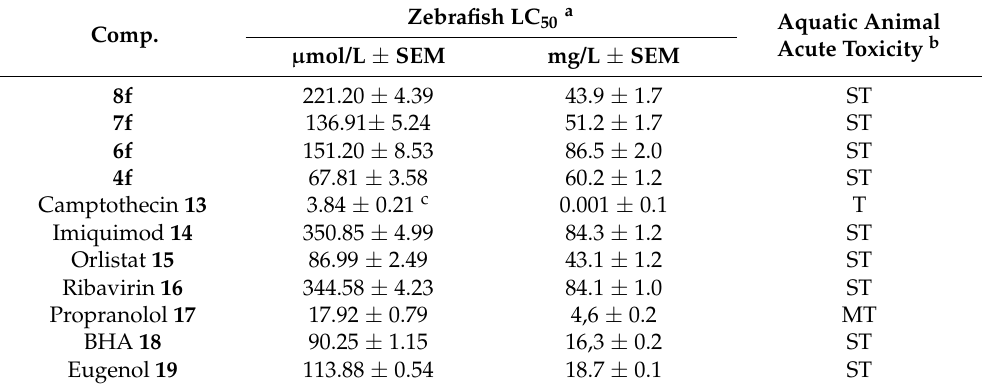
Table 2. Zebrafish embryo LC 50 values found for the pyridophenanthridin-6-one 4f and their corresponding precursors 6f – 8f and the selected positive